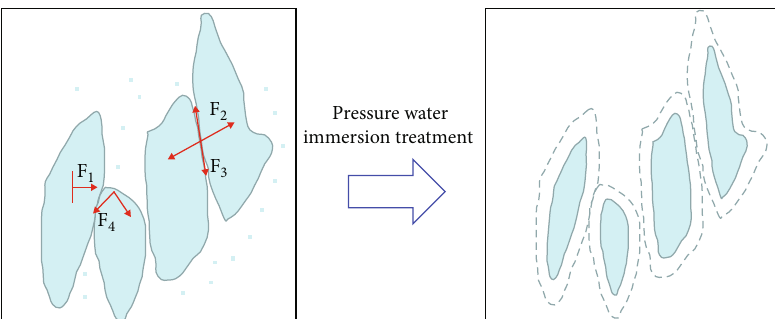
Figure 11: Diagram of deterioration of sandstone sample under pressurised water immersion